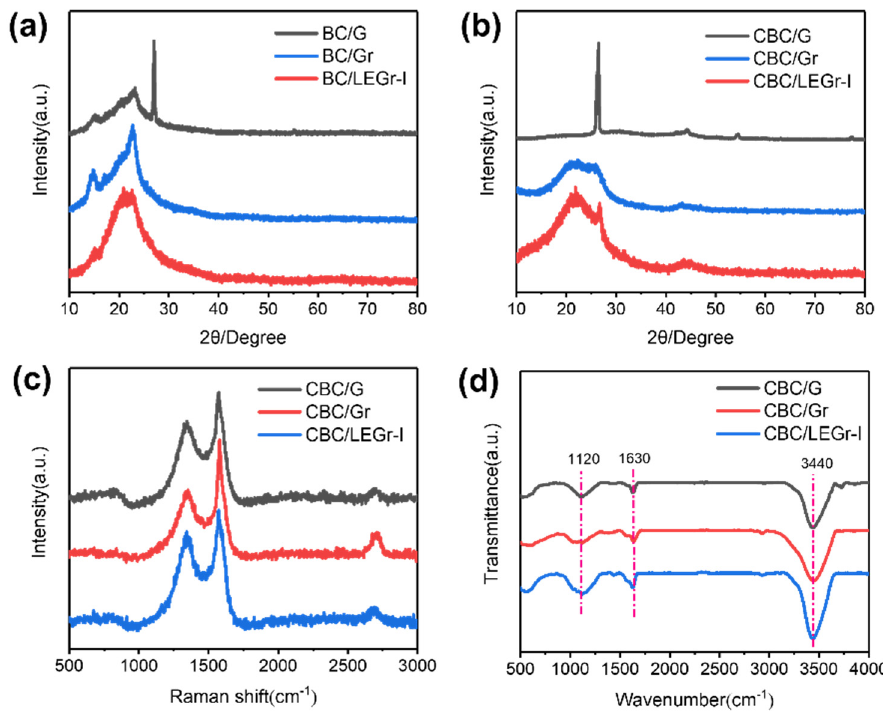
Figure 3. ( a ) XRD patterns of BC/G, BC/Gr, and BC/LEGr-I. ( b ) XRD patterns, ( c ) Raman-spectros- copies and ( d ) FT-IR spectrum of CBC/G, CBC/Gr, and